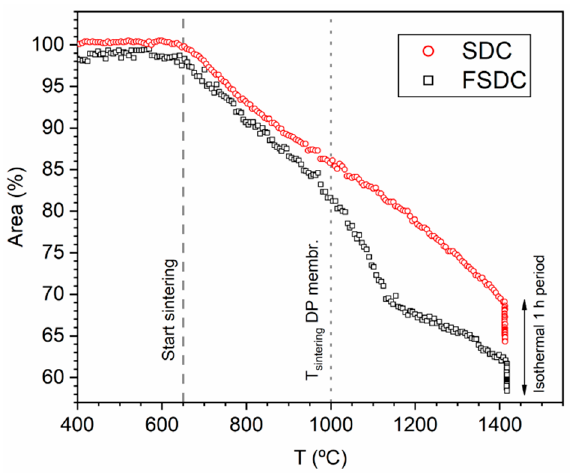
Figure 3. Sintering behavior of the SDC and FSDC powders characterized by HSM. Dashed line highlights the start of the sintering for both materials. Dotted line shows the sintering temperature of the later DP membranes.